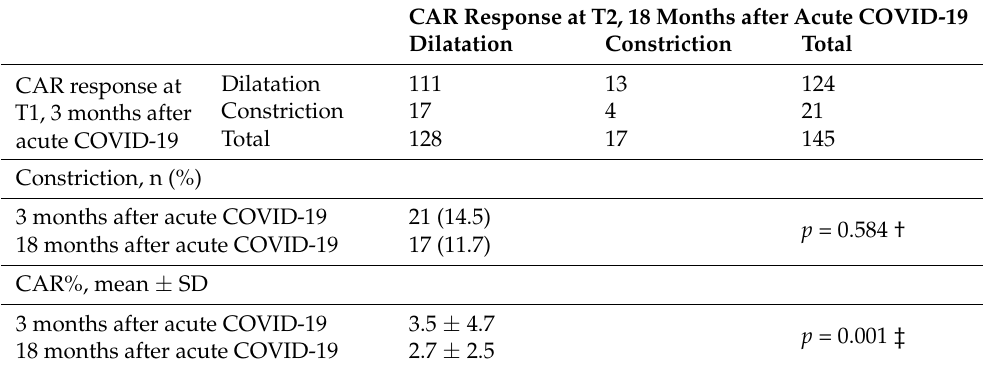
Table 2. Total participants with a vasodilatation and vasoconstriction response at 3 months and 18 months after acute COVID-19.